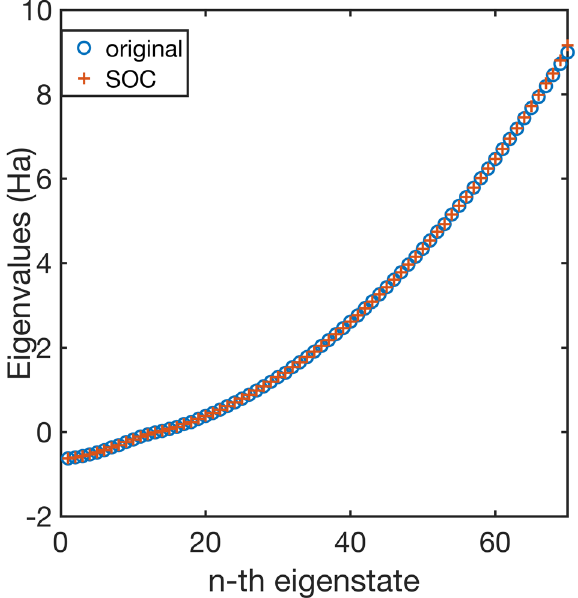
Fig. 3 Representability of the 1-D localized functions. Comparison of the eigenvalues of the 1-D separable Hamiltonian in x 1 direction of Al 147 nano-particle (marked with blue circle) with the eigenvalues of